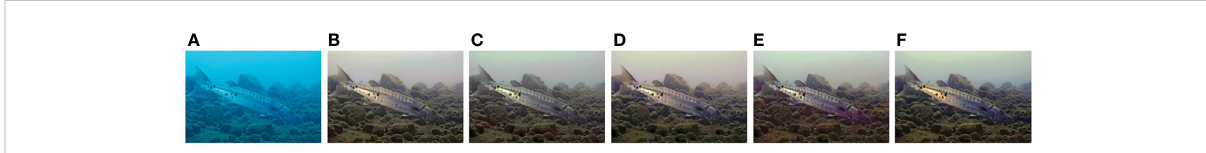
FIGURE 15 Visual results with different spiral loops. From left to right, (A) shows the raw underwater images, and (B – F) are the results of second loops, fourth loops, sixth loops, eighth loops and tenth loops (Ours),